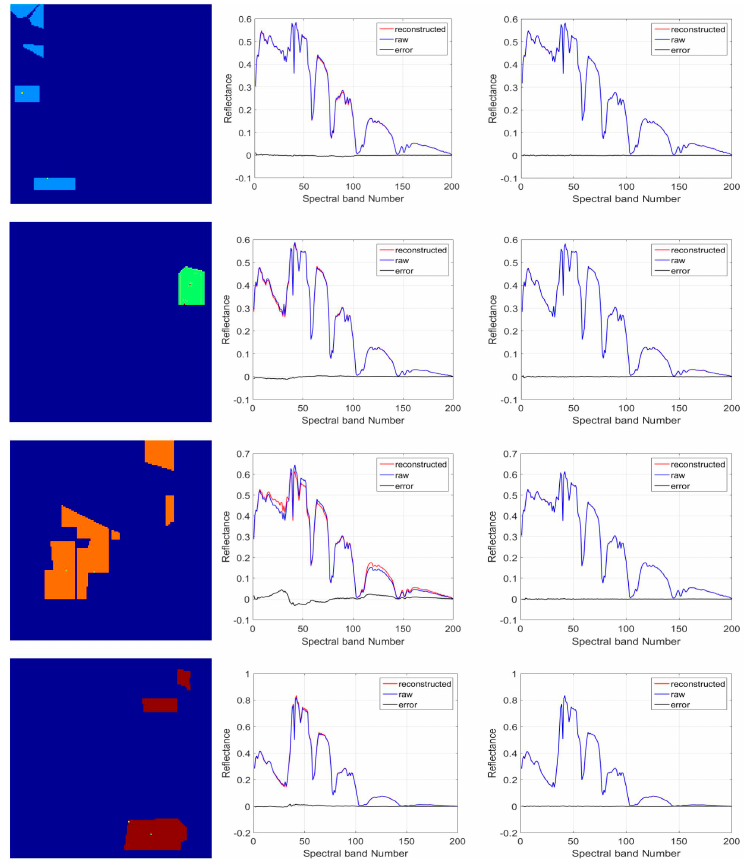
Figure 11. The reconstructions of the border-pixels and inner-pixels of different classes in Indian Pines. First row is the reconstruction information of Class 2, second row is the reconstruction information of Class 4, third row is the reconstruction information of Class 6 and last row is the reconstruction information of Class 8.